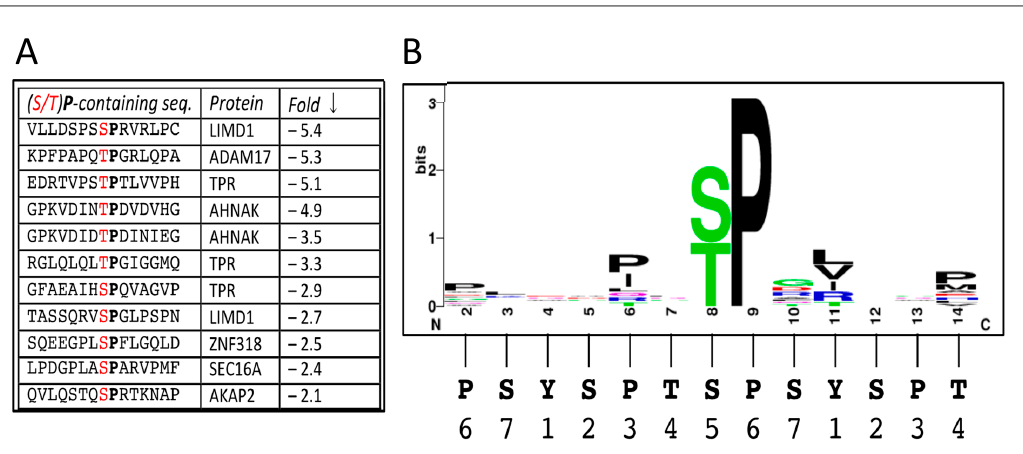
Figure 2. Potential consensus phosphorylation site for CDK12. The phospho-peptides that contain an (S / T)P dipeptide that decreased > 2-fold after CDK12 inhibition (from Supplementary File I, Table S5) are listed in ( A ) (first column), aligned on the phosphorylated S / T residue. The parent protein and the fold decrease are in the second and third columns, respectively. This sequence set was used to find a sequence logo using < weblogo.berkeley.edu > , with the logo range set to 3-14; results in ( B